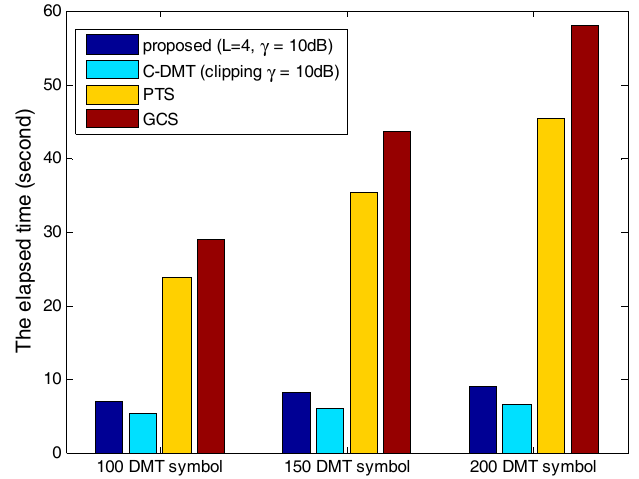
Figure 11. Comparisons of computational complexity for different scheme.